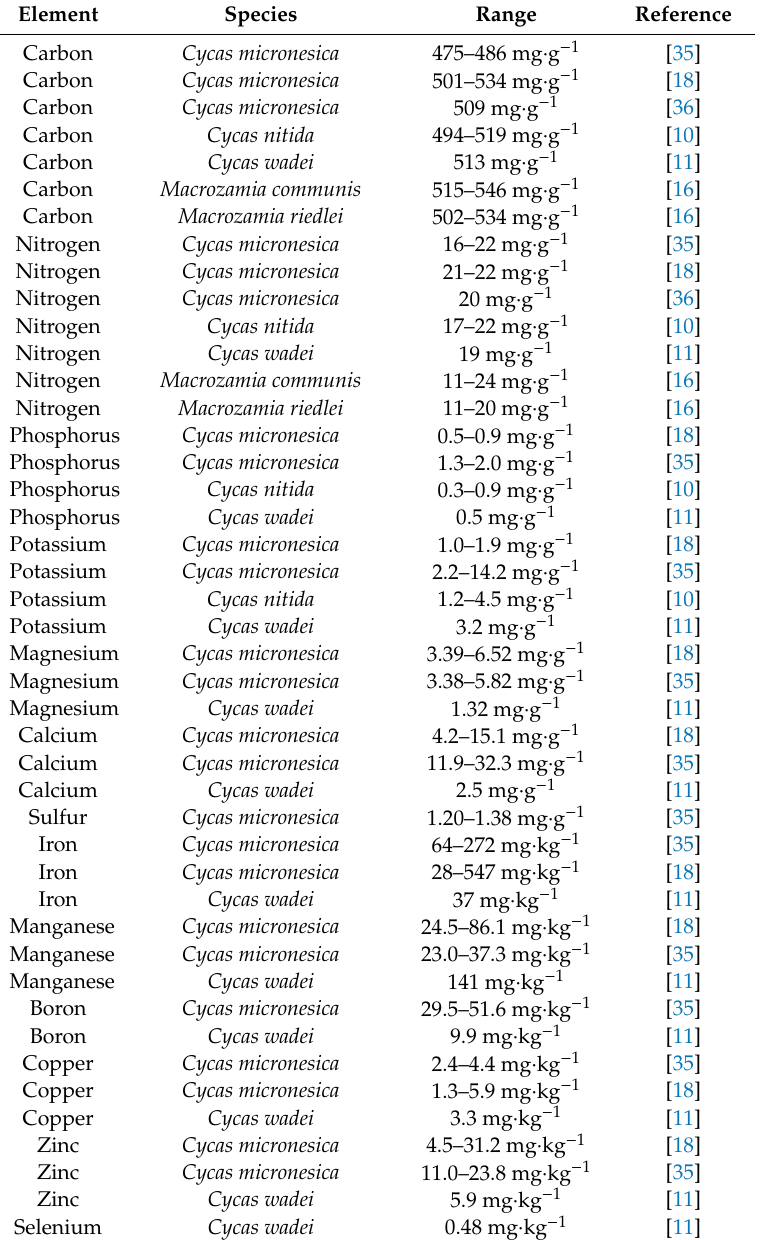
Table A2. Published ranges for leaf litter element concentrations of cycad plants. Misspellings of species were corrected if identity was obvious, species that were misspelled were not included if identity was not obvious. Taxonomic synonyms were corrected. Data were estimated for reports displaying data as figures and transformed if data were presented as